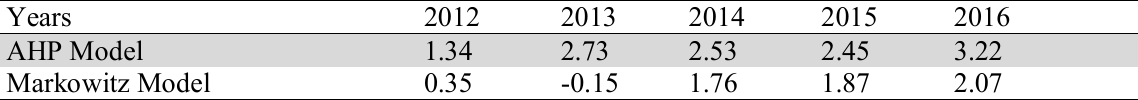
The comparison between Sharp ratio using AHP and Markowitz